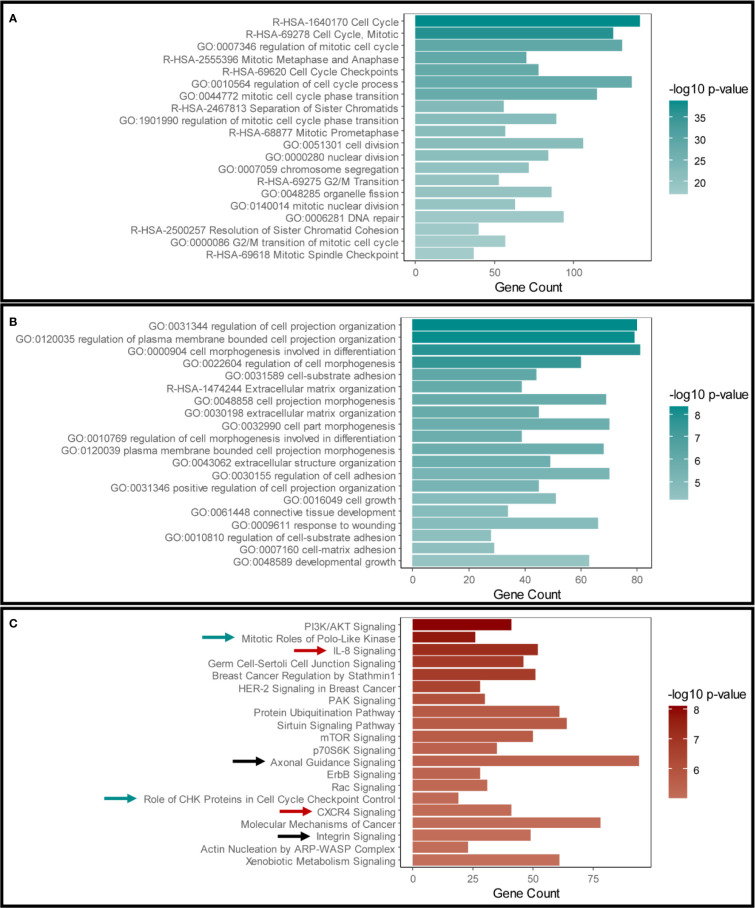
Validation of Snail inhibition and p53 restoration in GN25 treated cells. The top 20 enriched pathways and functional clusters in (A) the upregulated genes and (B) downregulated genes in the GN25 treated cells analyzed using Metascape annotation tool (C). Top 20 pathways enriched in the differentially expressed genes in GN25 treated cell (both up- and down-regulated genes) using IPA. Green arrows indicate cell cycle related pathways; black arrows indicated cell morphogenesis related pathways; and black arrows indicate immune response related pathways.